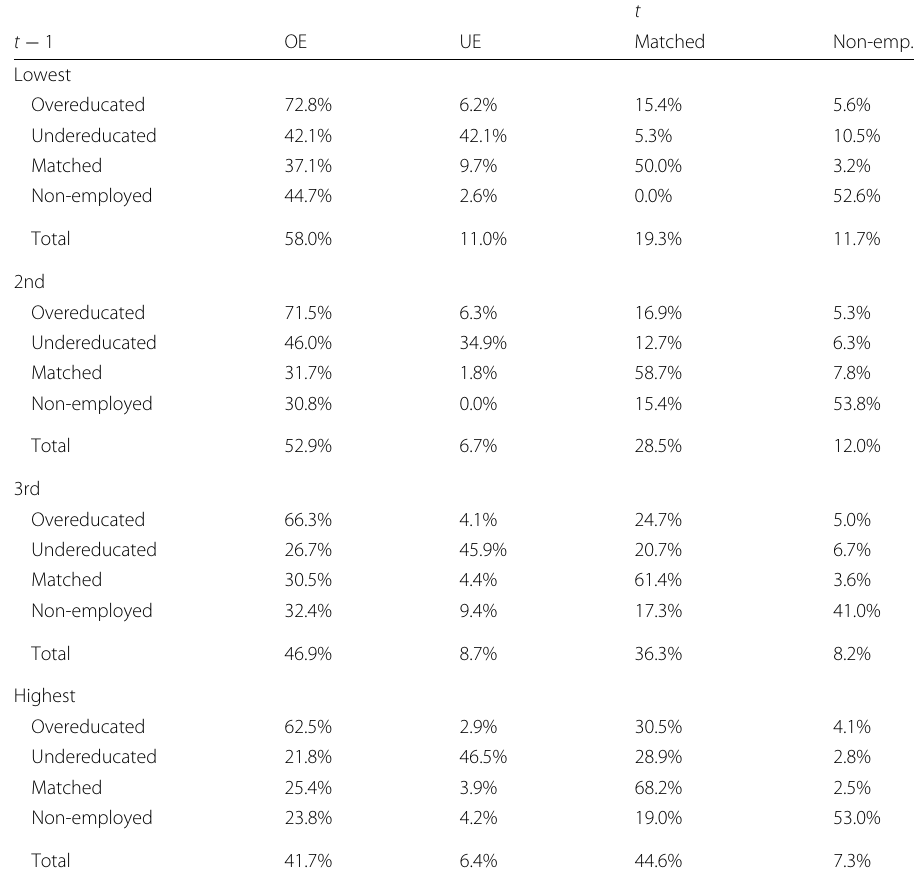
Table 8 Transition matrix by AFQT